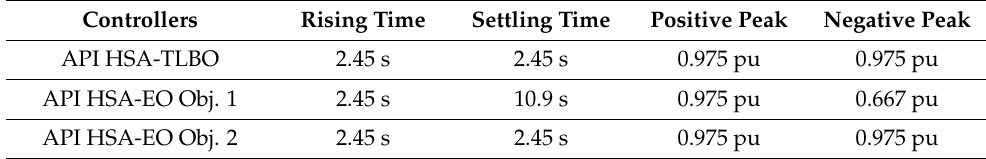
Table 5. Statistical analysis of the active power—normal second case.